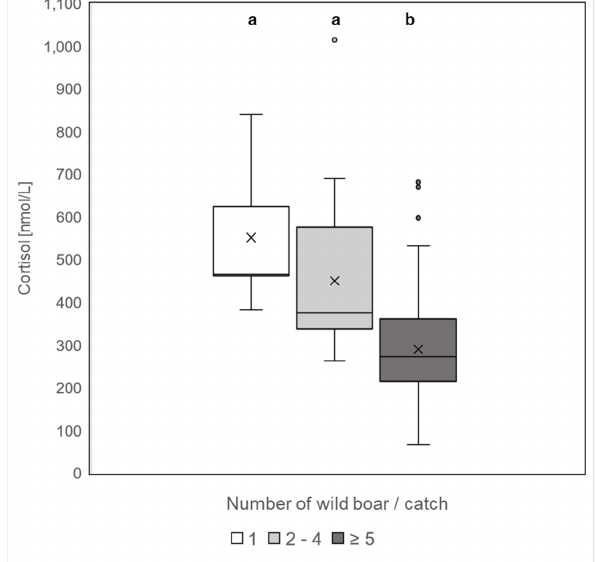
Figure 3. Concentration of cortisol levels of wild boar trapped and shot in corral-style traps of various group sizes. Single wild boar caught and shot in corral-style traps ( n = 7) showed higher cortisol levels than wild boar in groups of 2–4 ( n = 26) and in groups greater than or equal to 5 ( n = 105). Different superscripts (a, b) indicate significant differences in pairwise comparisons ( p < 0.05).